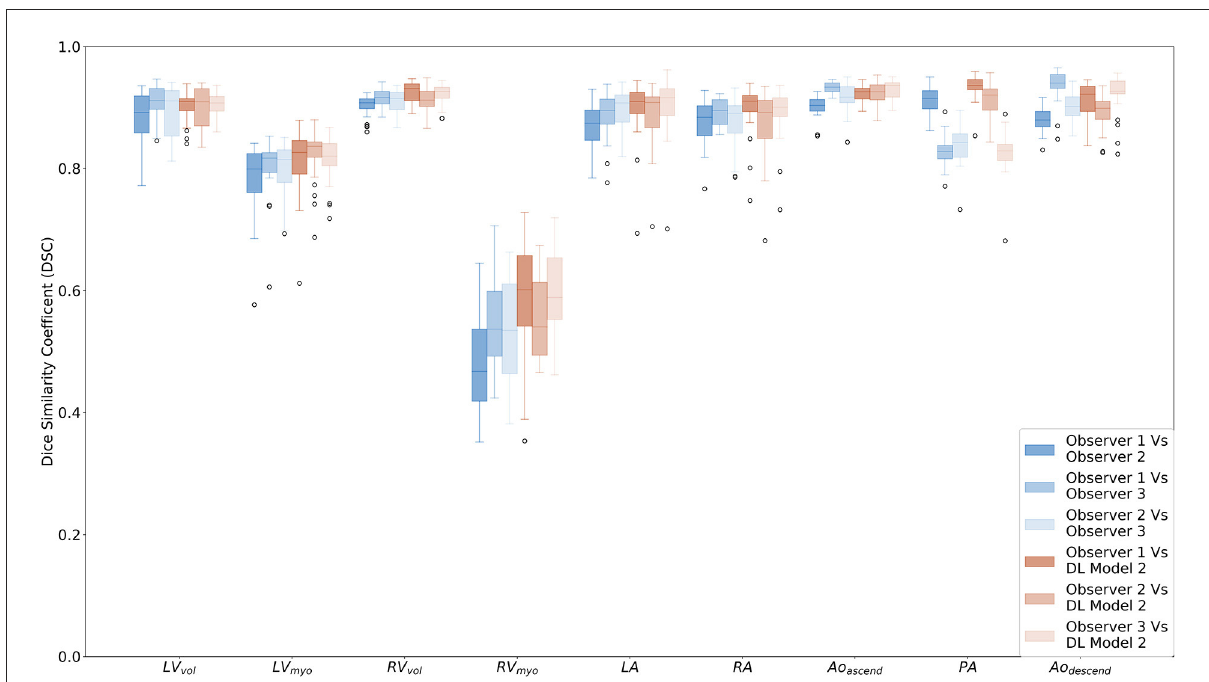
FIGURE2 Box plots comparing Dice similarity coefficients (DSC) for the segmented cardiac structures for observers 1 (AJS), 2 (KK) and 3 (CJ) and DL model 2 in the interobserver comparison cohort ( n = 24). Structures are as follows; LV endocardial cavity (LV vol ), LV myocardium (LV myo ), RV